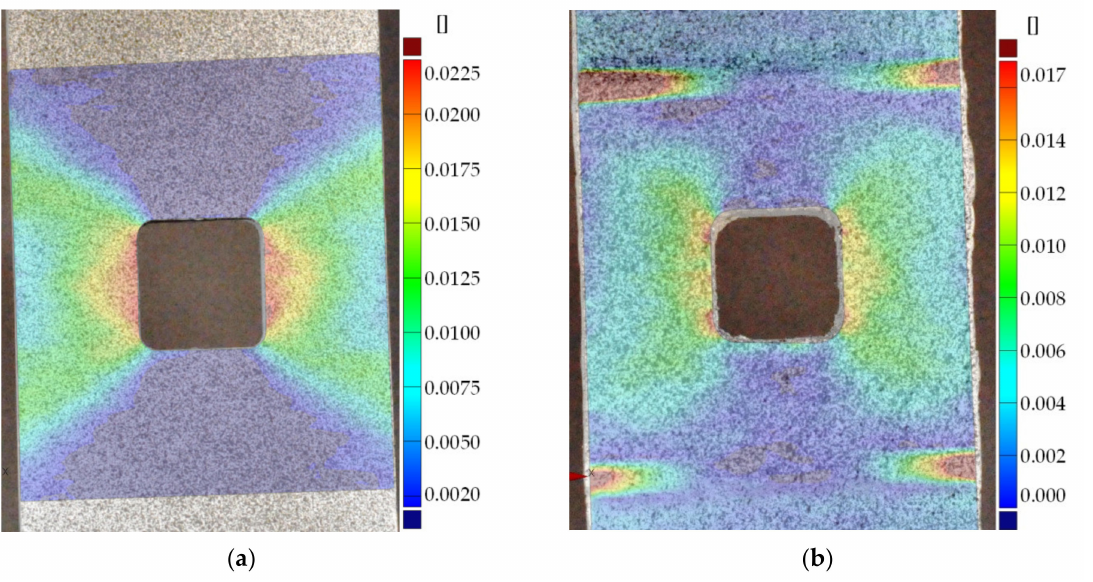
Figure 21. Surface strains determined from DIC analyses (total strain ε TOT = 0.48%): ( a ) sample no. 16 without overlays; ( b ) sample no. 18 with composite Hexcel TVR 380 [+45 ◦ / − 45 ◦ ] 4